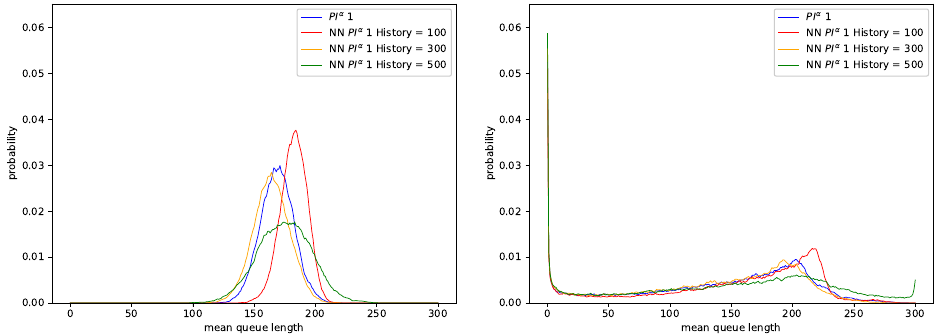
Figure 4. Distribution of queue length obtained for CNN model with the last layer activation function Softmax, trained using data regarding PI α 1 controller and parameters: K P = 0.0001, K I = 0.0004, α = − 0.4, H = 0.5 ( left ), H = 0.9 ( right